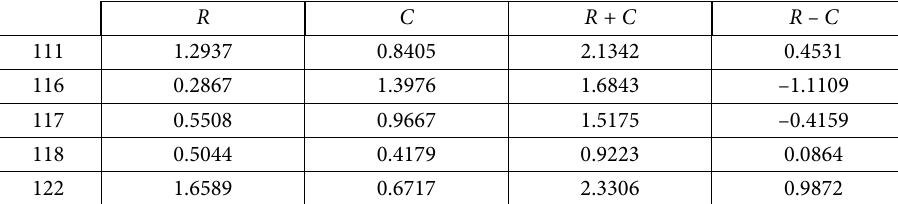
Table 24. Auxiliary calculations for C5 Training